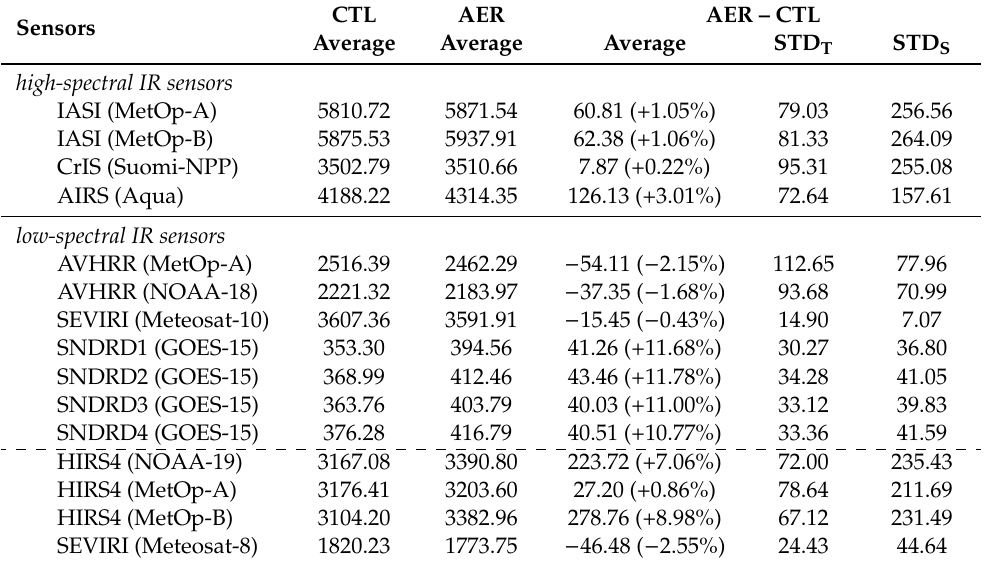
Table 5. Average assimilated observations number among infrared sensors over 1–28 August 2017. Rows below the dash line are monitored-only sensors. STD T and STD S stand for the temporal and spectral standard deviation of difference between AER and CTL, respectively. The relative changes of each sensor in AER are indicated in the